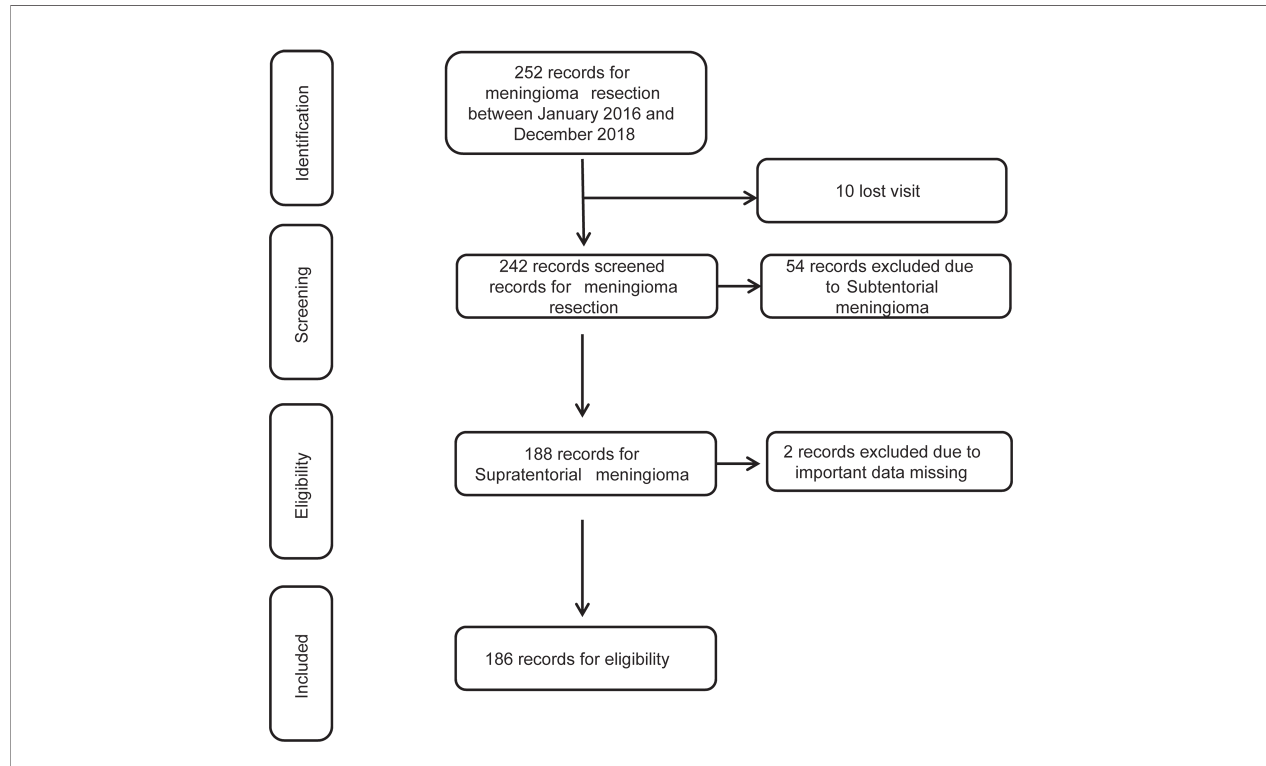
FIGURE 1 | Flow chart of